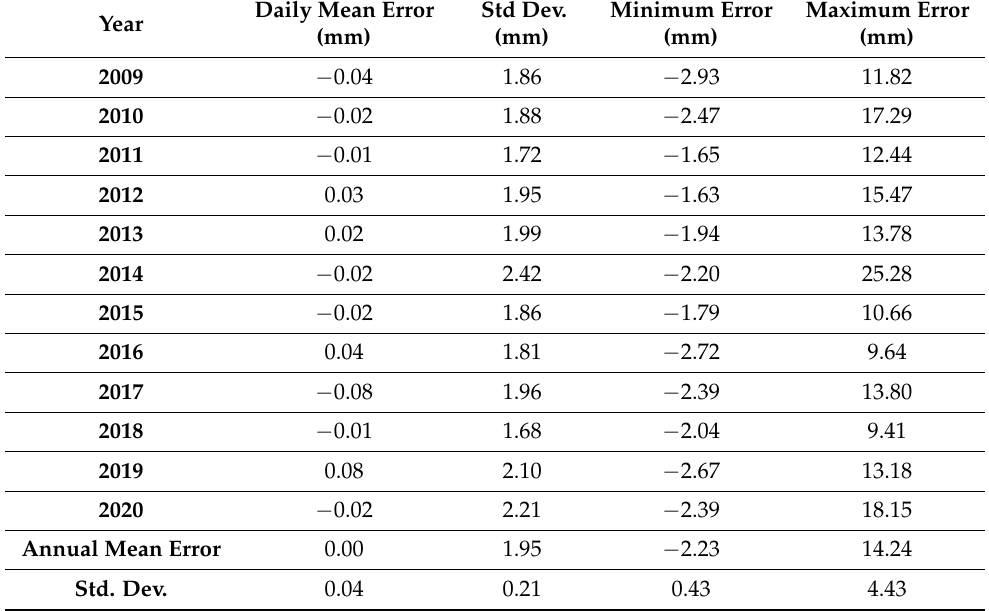
Table A3. Daily mean, standard deviation, minimum and maximum water balance e errors at Orocovis, Puerto Rico. Table also includes annual values. Table also includes annual values. All values are in